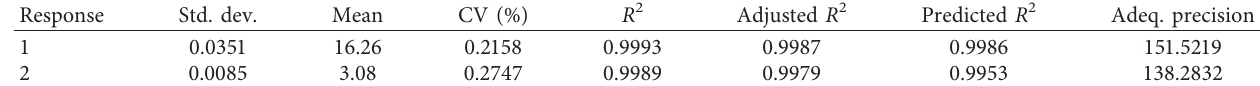
Table 7: Fit summary.